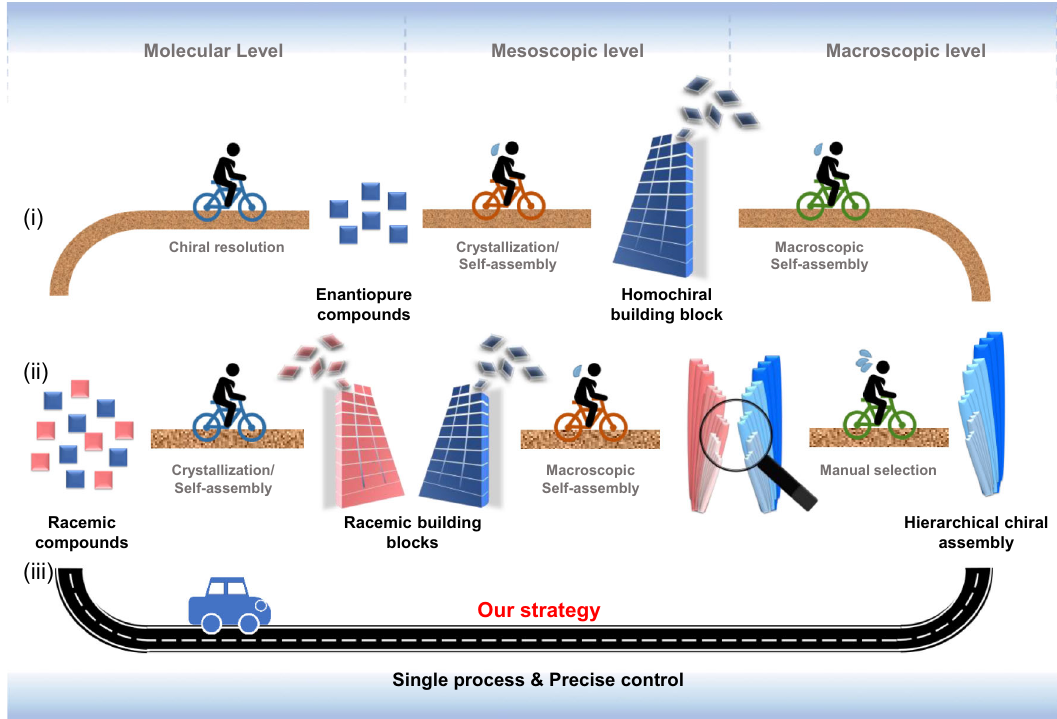
Fig. 1 Scheme of concepts. Route i: Enantiopure molecules are obtained through chiral resolution, form enantiopure crystals and one-handed crystal aggregates. Route ii: Racemic compounds form a pair of enantiomorphs through a self-sorting process, which then aggregate into chiral crystal aggregates with opposite sense, separately. Manual selection is needed to obtain optically active structures. Route iii: In this work, the hierarchical chiral structures are directly generated from racemic solutions in a single